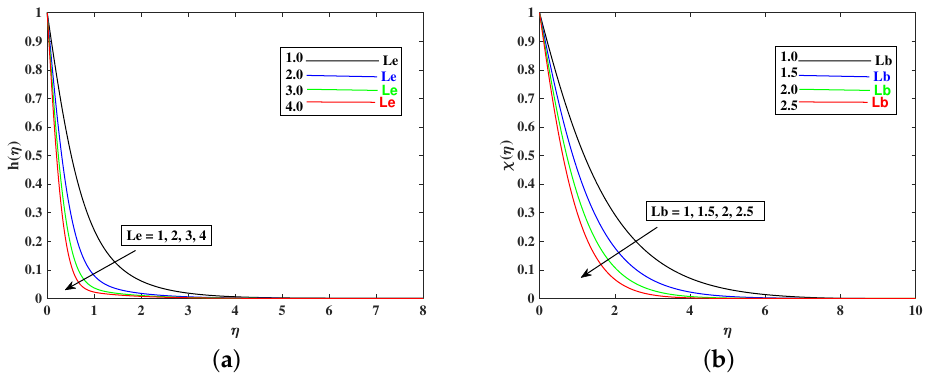
Figure 13. Variation of Le and Lb to influence the concentration and bioconvection profile. ( a ) Variation of Le to influence the concentration profile. ( b ) Variation of Lb to influence the bioconvection profile.